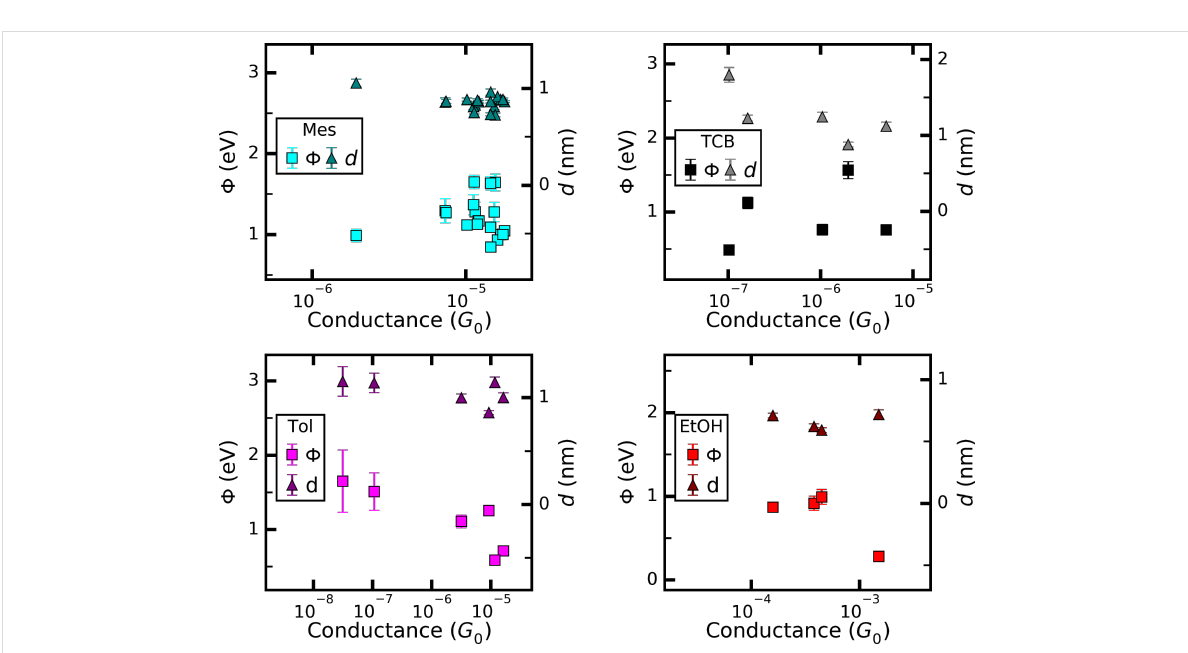
Figure 6: Results of fitting with SM, Equation 2. The error bars denote the numerical error of the least-squares fitting of the individual